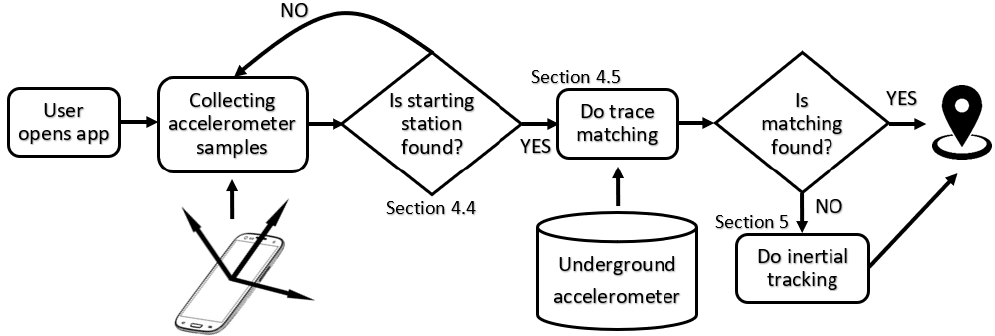
Figure 12. The decision process of doing real-time trace matching and inertial